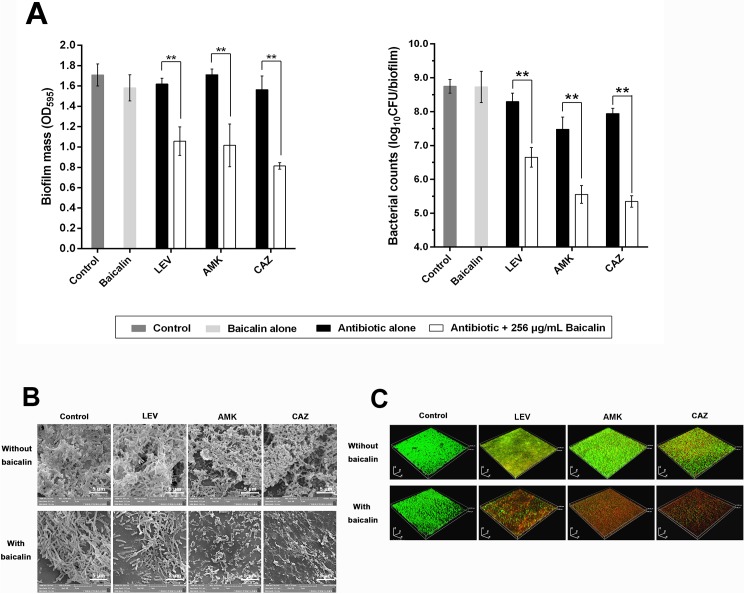
Baicalin as a co-treatment in combination with three conventional antibiotics to treat 96-h P. aeruginosa PAO1 biofilms.(A) P. aeruginosa PAO1 biofilm mass and bacterial counts were quantified after treating pre-existing 96-h biofilms with sub-MIC (256 μg/mL) of baicalin for another 24 h. Experiments were performed in triplicate, and values represent the mean ± standard deviation. **P<0.01 compared with the vehicle control group. (B) Images show 96-h biofilms observed by SEM (10000× magnification). (C) Three-dimensional reconstructions of 96-h P. aeruginosa PAO1 biofilms were created using CLSM (200× magnification).